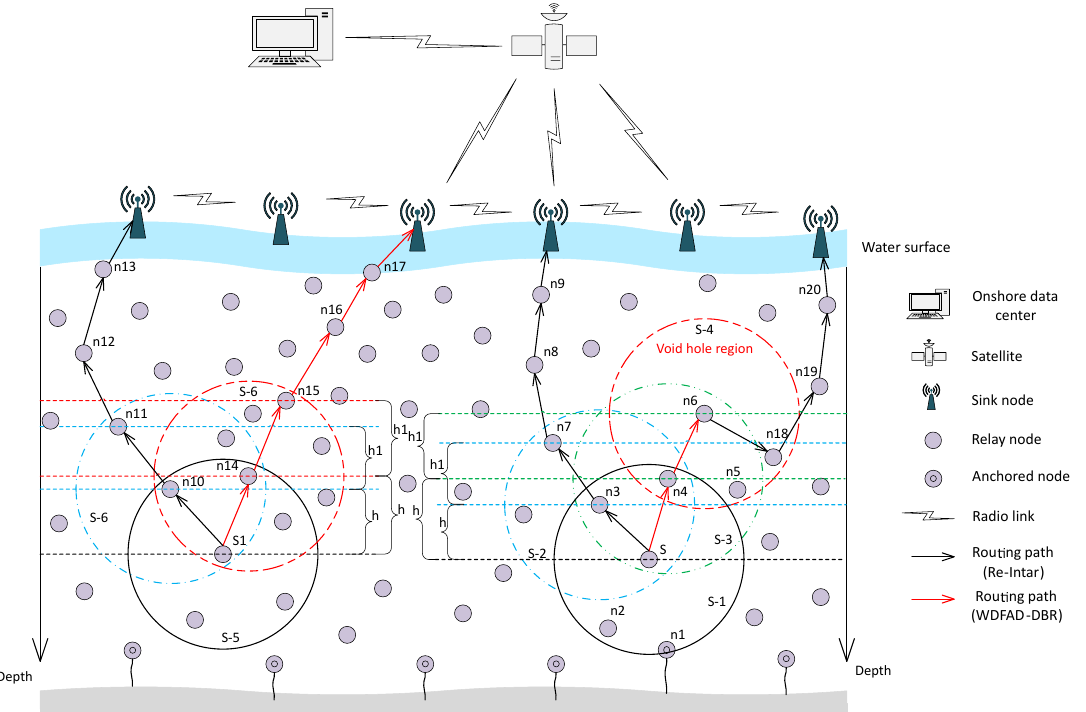
Figure 1. Network architecture of the proposed Re-Intar, illustrating void hole problem and collision